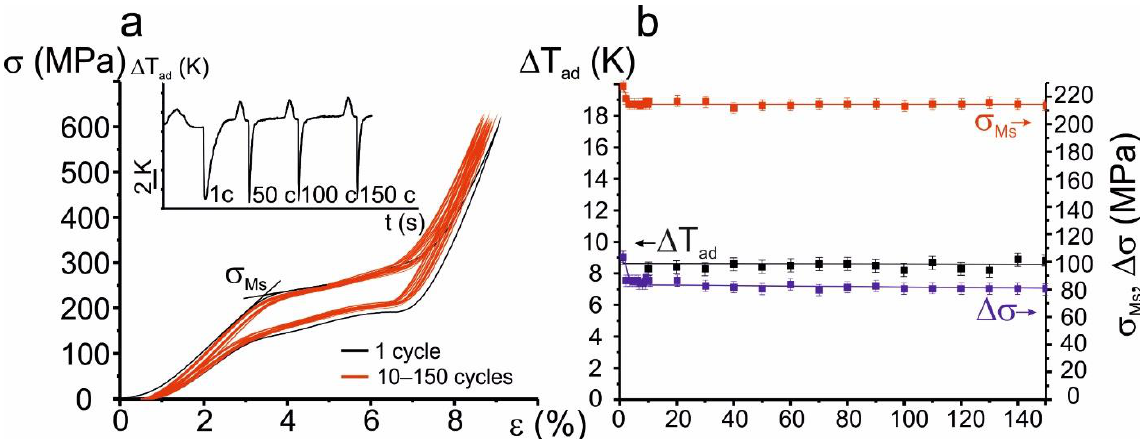
Figure 8. Compressive functional fatigue responses and EC fatigue at T=373 K in aged 1373 K, 0.5 h Ni 54 Fe 19 Ga 27 single crystals oriented along the [001] A -direction: the dependence of SE curves with corresponding thermograms on number of cycles ( a ) and the dependence of adiabatic temperature change ΔT ad, critical stresses of forward MT σ Ms and stress hysteresis Δσ on number of cycles ( b ).